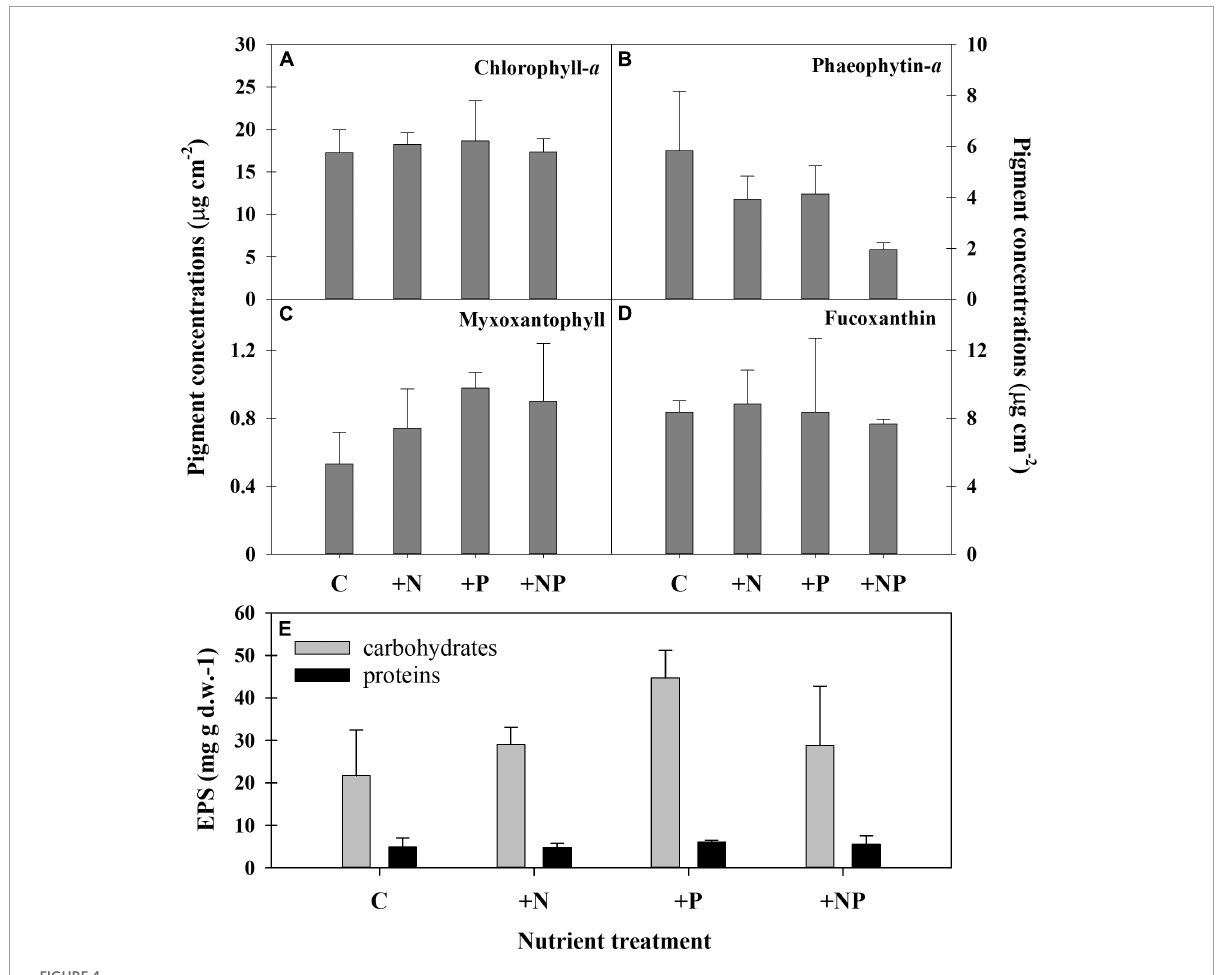
FIGURE4 Pigment concentrations in the different experimental conditions at the end of the experiment. (A) Chlorophyll a , (B) phaeophytin-a, (C) myxoxantophyll (cyanobacteria biomarker), (D) fucoxanthin (diatom biomarker). C refers to the control treatment. (E) Content of two exopolymeric substances (EPS) fractions (carbohydrates and proteins) in the different treatments at the end of the experiment.